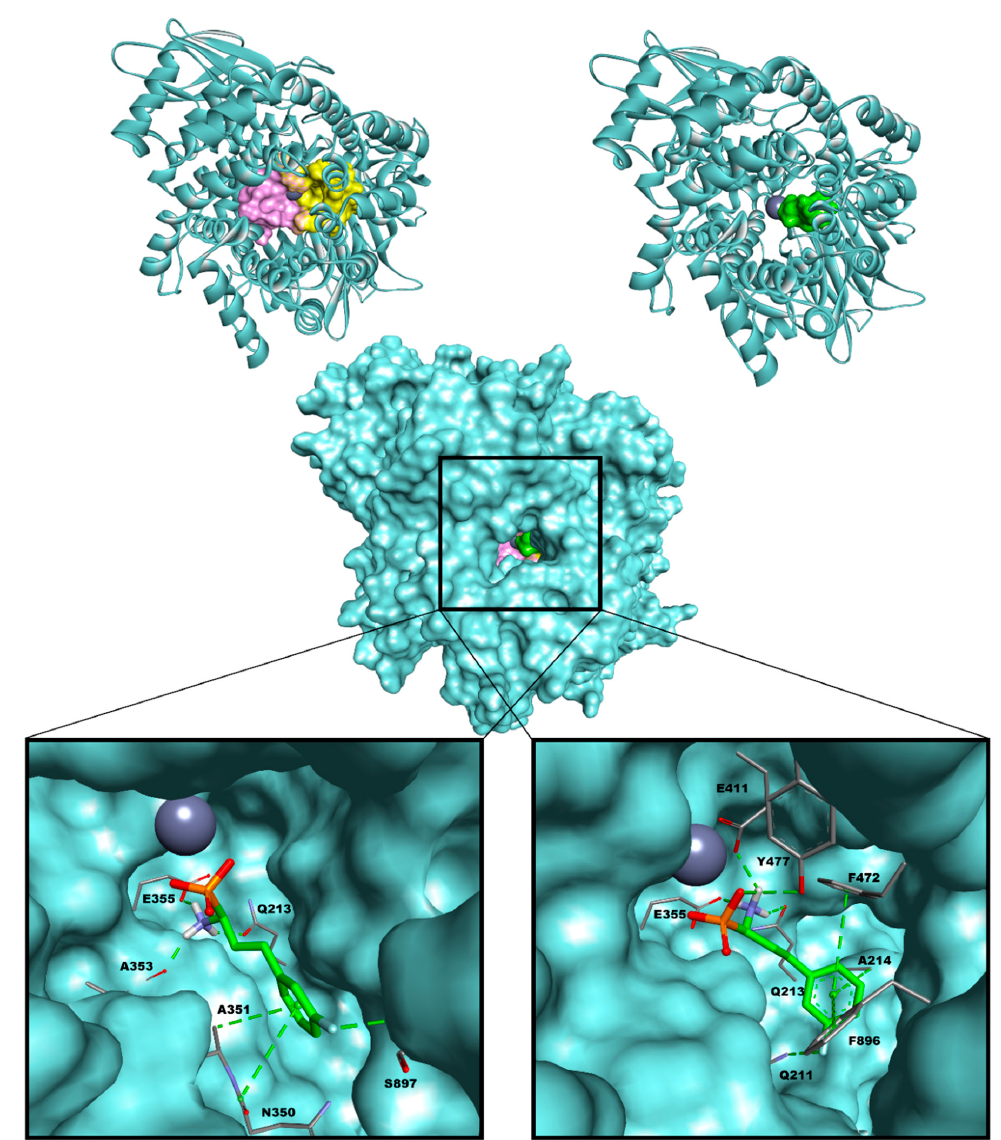
Figure 2. General view of the crystal structure of hAPN (PDB: 4FYT) with marked substrate cavities S1 (yellow) and S1 ꞌ (pink) in the lack and presence of inhibitor (green). The interactions of the enzyme with compound 15c are shown as representative example. The isomer (S) is on the left side, when the (R) -isomer is on the right side of the Figure. The coloring scheme is identical as in Figure 1. In the case of replacement of chlorine atoms in already described inhibitors of hAPN [10] by more bulky bromine, resulting in compounds 17a–17e , did not bring expected results and the novel inhibitors are only slightly more effective than their counterparts. Although bromine fills well the hydrophobic pocket S1 and interacts with several of its amino acid side chains simultaneous shift of the inhibitor away from the bottom of S1 cavity causes that it is not optimally bound. This is well illustrated by the architectures of the complexes of both enantiomers of compound 17b and hAPN (Figure 3).